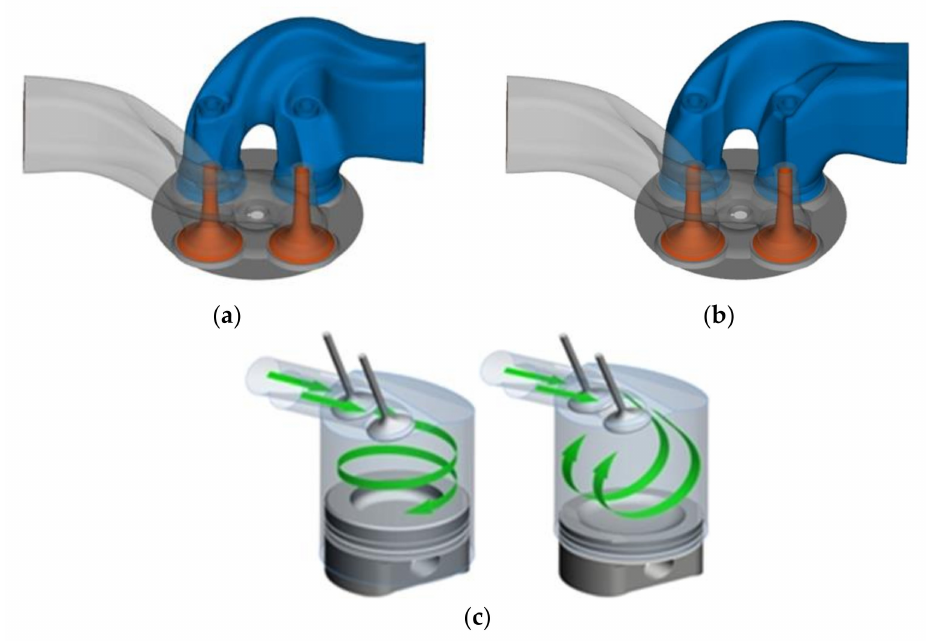
Figure 3. Comparison of the ( a ) SIP, ( b ) MFIP structures, and ( c ) large-scale in-cylinder flow. The CFD simulation was conducted to reveal the difference in the in-cylinder flow of the two intake ports as the basis for the subsequent engine performance analysis. Figure 4 compares the SIP and MFIP in Swirl Ratio (SR), Tumble Ratio (TR), and average TKE under the low-speed torque point of 1000 rpm, 2150 N · m. The term SR is defined by Equation (1), where L d represents the engine shape factor, C f represents the flow coefficient, N R represents the dimensionless swirl, α 1 and α 2 represent the crank angle when the intake valve opens and closes. Moreover, the definition of TR is similar.